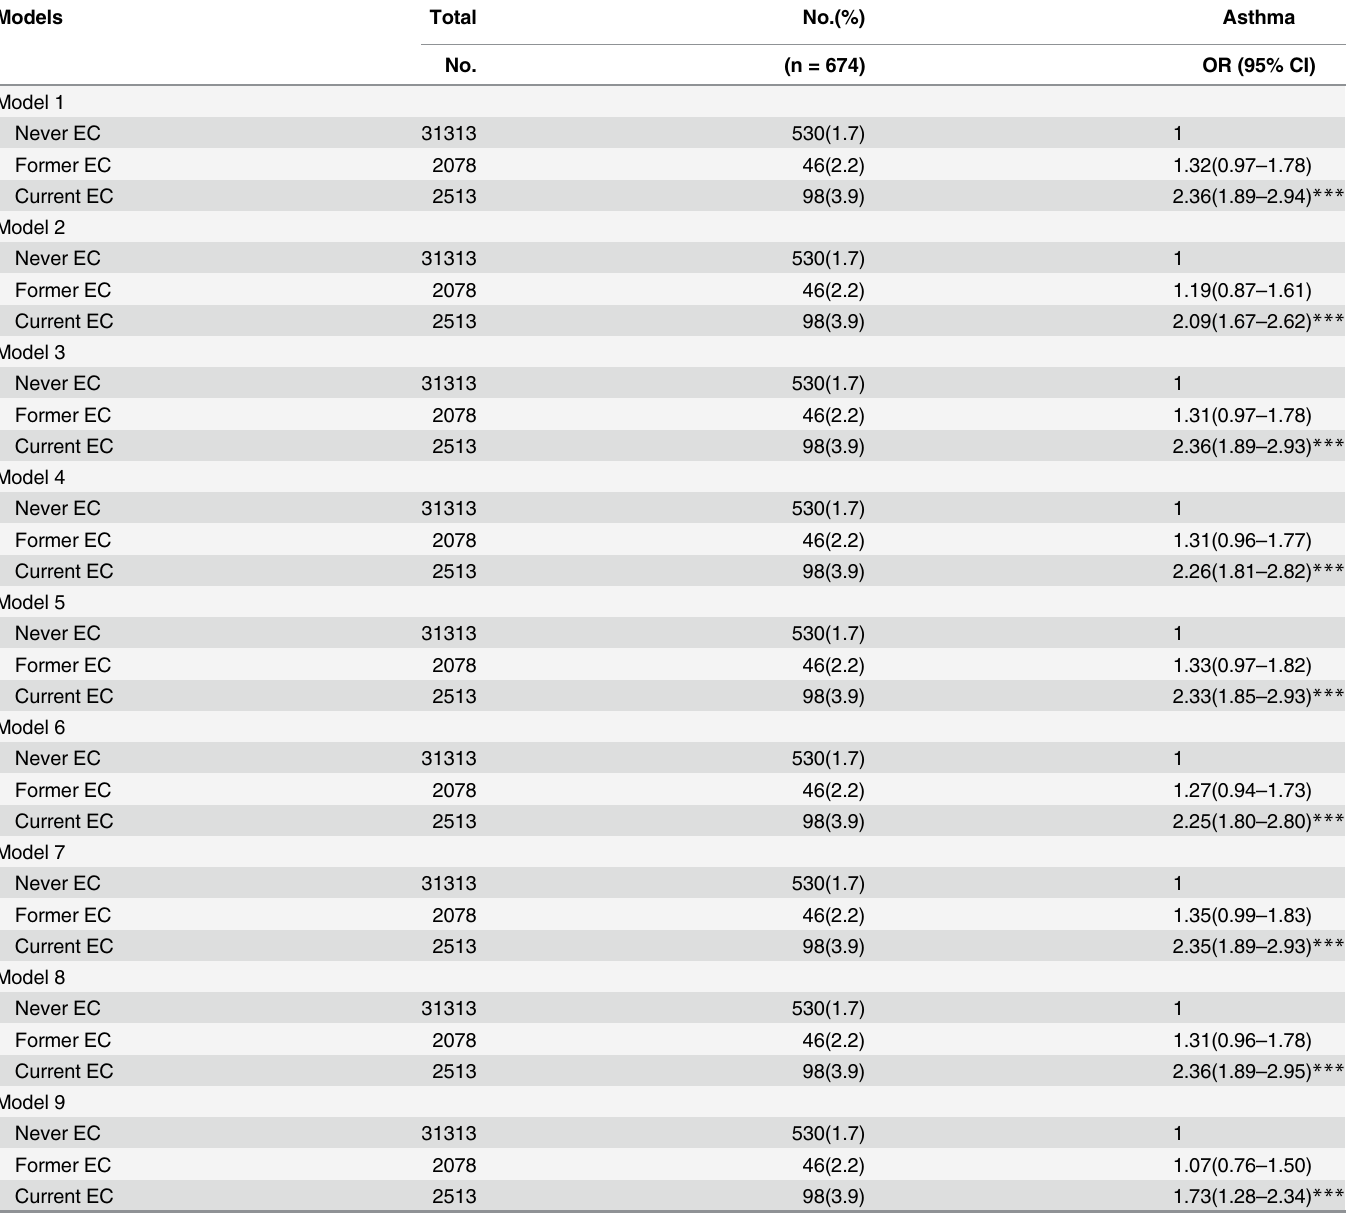
Table 3. Results of multiple logistic regression analyses for each potential confounder on the effect of EC on